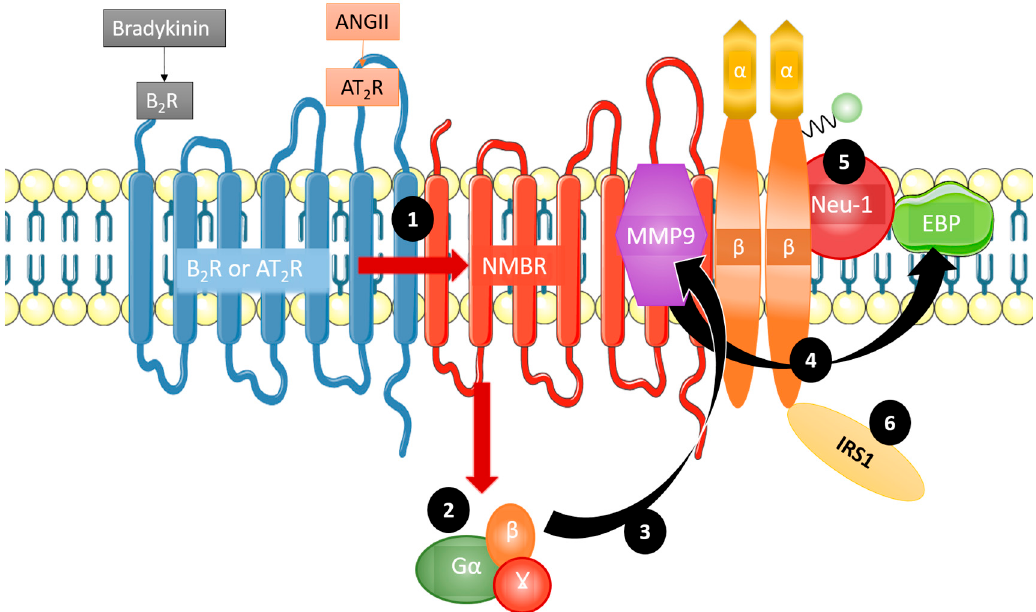
Figure 2. Mechanism of GPCR agonism bias towards insulin receptor activation. Bradykinin and angiotensin II are complexed with the neuromedin B receptor (NMBR), IR β , and Neu-1. Bradykinin and angiotensin II preferentially lead to insulin receptor signaling by first forming a complex with NMBR (1). This heterodimerization leads G α , β , and γ (2) to activate MMP-9 (3). Upon activation, MMP-9 removes EBP (4), which in turn activates Neu-1 (5). Crosstalk between these activated components leads to the phosphorylation and subsequent activation of insulin receptor substrate 1 (IRS1) (6), initiating the phosphoinositide 3-kinase - protein kinase B (PI3K-AKT) pathway, in addition to others, without the presence of insulin. Taken in part from Haxho et al [8] © 2017 The Authors © 2017 Published by Elsevier Inc. https://doi.org/10.1016/j.cellsig.2017.12.006. The CC-BY license allows users to copy, to create extracts, abstracts and new works from the Article.